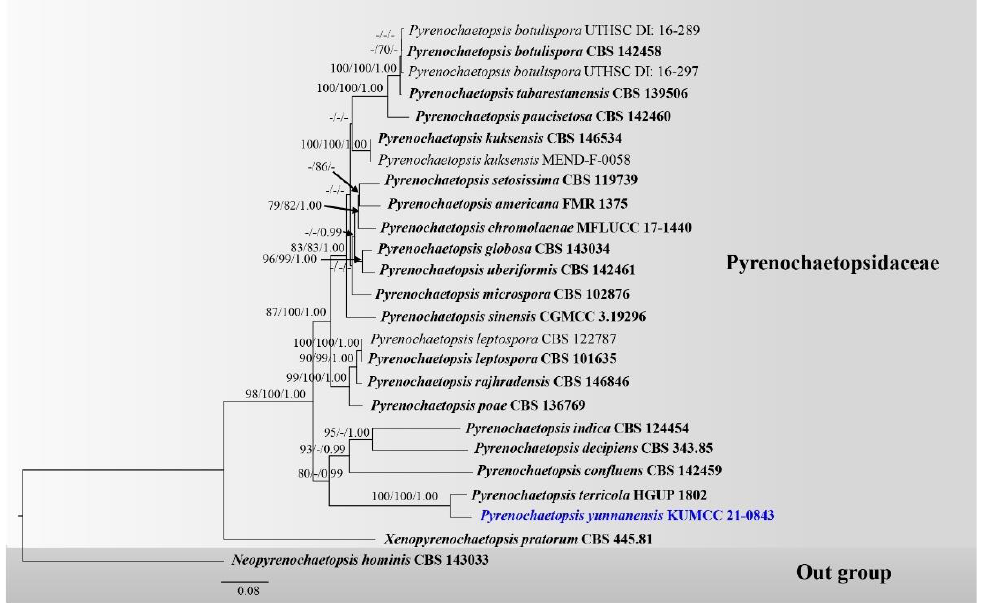
Figure 3. Phylogram generated from RAxML analysis of a concatenated LSU-ITS- rpb2 - tub2 se- quence dataset to represent the phylogenetic relationships of a novel taxon in Pyrenochaetopsidaceae. Bootstrap support values for ML and MP equal to or greater than 70% and the Bayesian posterior probabilities equal to or higher than 0.95 PP are indicated above the nodes as ML/MP/PP. Support values lower than 70% ML/MP and 0.95 PP are indicated by a hyphen (-). Ex-type strains are in bold, and the new species is indicated in blue. The arrow is indicated the support value at the node.